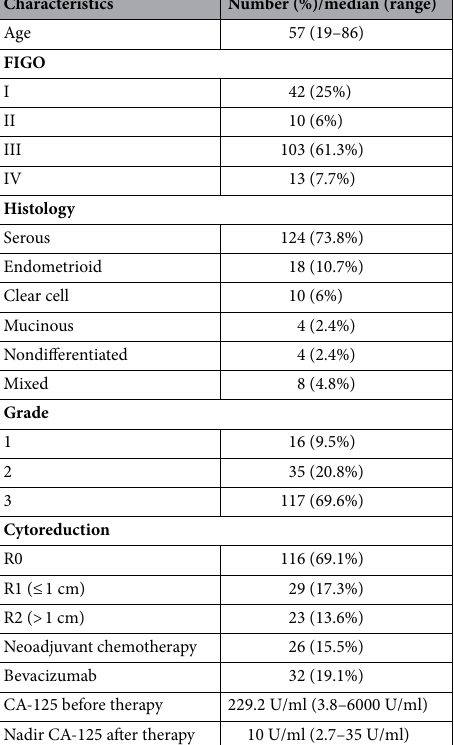
Table 1. Patient characteristics. The data in the table correspond to those presented in a previous study 10 .